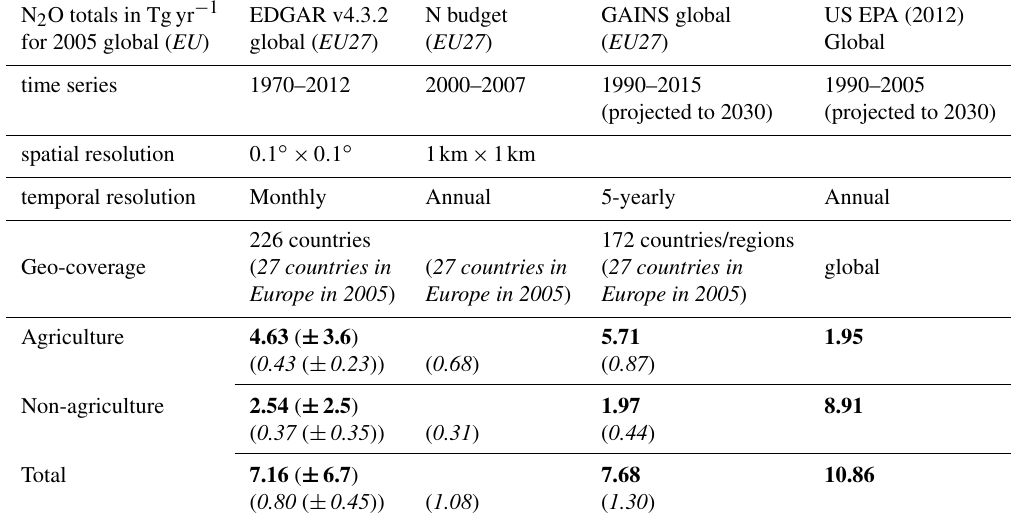
Table 5. Intercomparison of the global ( EU ) total TgN 2 O in 2005 by EDGAR v4.3.2 and by other European and global inventories: the European N Assessment of Leip et al. (2011) for EU27, GAINS Europe of Höglund-Isaksson et al. (2010) and GAINS global of Winiwarter et al. (2018), global total of US EPA (2012). The global values are bold, and the European values are given in italics between